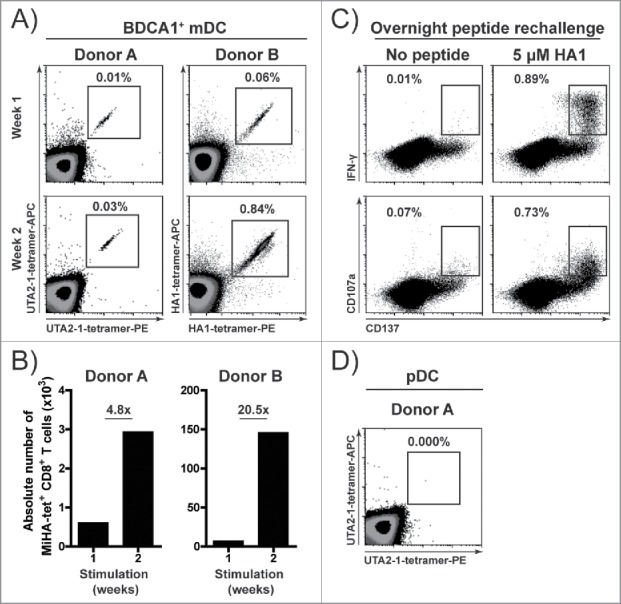
HSPC-derived BDCA1+ mDCs efficiently prime and activate naïve MiHA-specific T cells. HSPC-DCs were generated as described in Fig. 1, and subsequently BDCA1+ mDCs were sorted from G4 culture and pDCs from FST culture. Next, BDCA1+ mDCs were stimulated with R848 and Poly I:C (RPI:C) in the presence of GM-CSF and IL-4, while pDCs were stimulated with R848 in the presence of IL-3. (A–B) Purified CD8+ T cells from MiHA-negative HLA-A2+ donors were cultured for two consecutive weeks with autologous MiHA peptide-loaded TLR-matured BDCA1+ mDCs. Cells were screened for the presence of MiHA-specific CD8+ T cells using flow cytometry on days 7 and 14. Density plots (A) and absolute MiHA-specific CD8+ T cell numbers (B). (C) BDCA1+ mDC-primed and expanded MiHA-specific T cells of donor B were overnight rechallenged with or without 5 µM HA1-peptide at day 14, followed by intracellular staining for CD137, IFN-γ and CD107a. (D) Purified CD8+ T cells from MiHA-negative HLA-A2+ donor were cultured for one week with MiHA-loaded TLR-matured pDCs. Presence of MiHA-specific CD8+ T cells was determined by flow cytometry on day 7. (A, C–D) The numbers in the dot plots represent the percentage of tetramer-positive cells within CD3+CD8+ T cells.